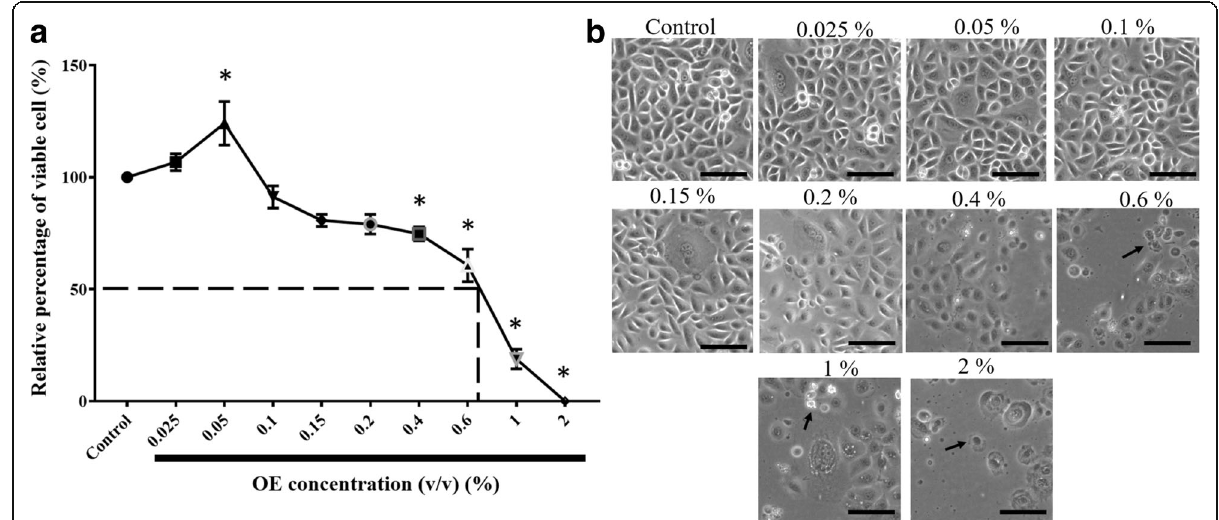
Fig. 1 a Cytotoxicity of OE determined by MTT assay. * P < 0.05: significantly different from control. b Morphology of RECs treated with several concentrations of OE for 24 h (arrow showing round and shrunken cells)